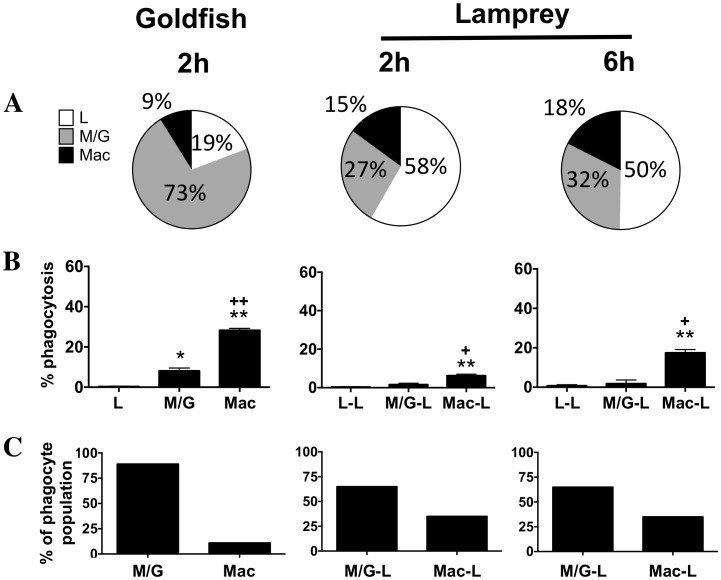
Macrophages are the dominant phagocyte of goldfish and lamprey primary hematopoietic tissues.(A) Goldfish PKL and lamprey PTL were incubated with zymosan (5∶1 ratio) for the specified times. The total leukocyte pool was broken down into cellular subpopulations based on morphology and flow cytometry forward and side scatter parameters. (B) The percent of phagocytic cells from each subpopulation previously determined in (A). * p<0.05 and ** p<0.01 compared to lymphocytes;+p<0.05 and++p<0.01 compared to monocytes/granulocytes. (C) The percent of monocytes/granulocytes and macrophages that make up the professional population of phagocytes. For all n = 4, examined over a minimum of two independent experiments.